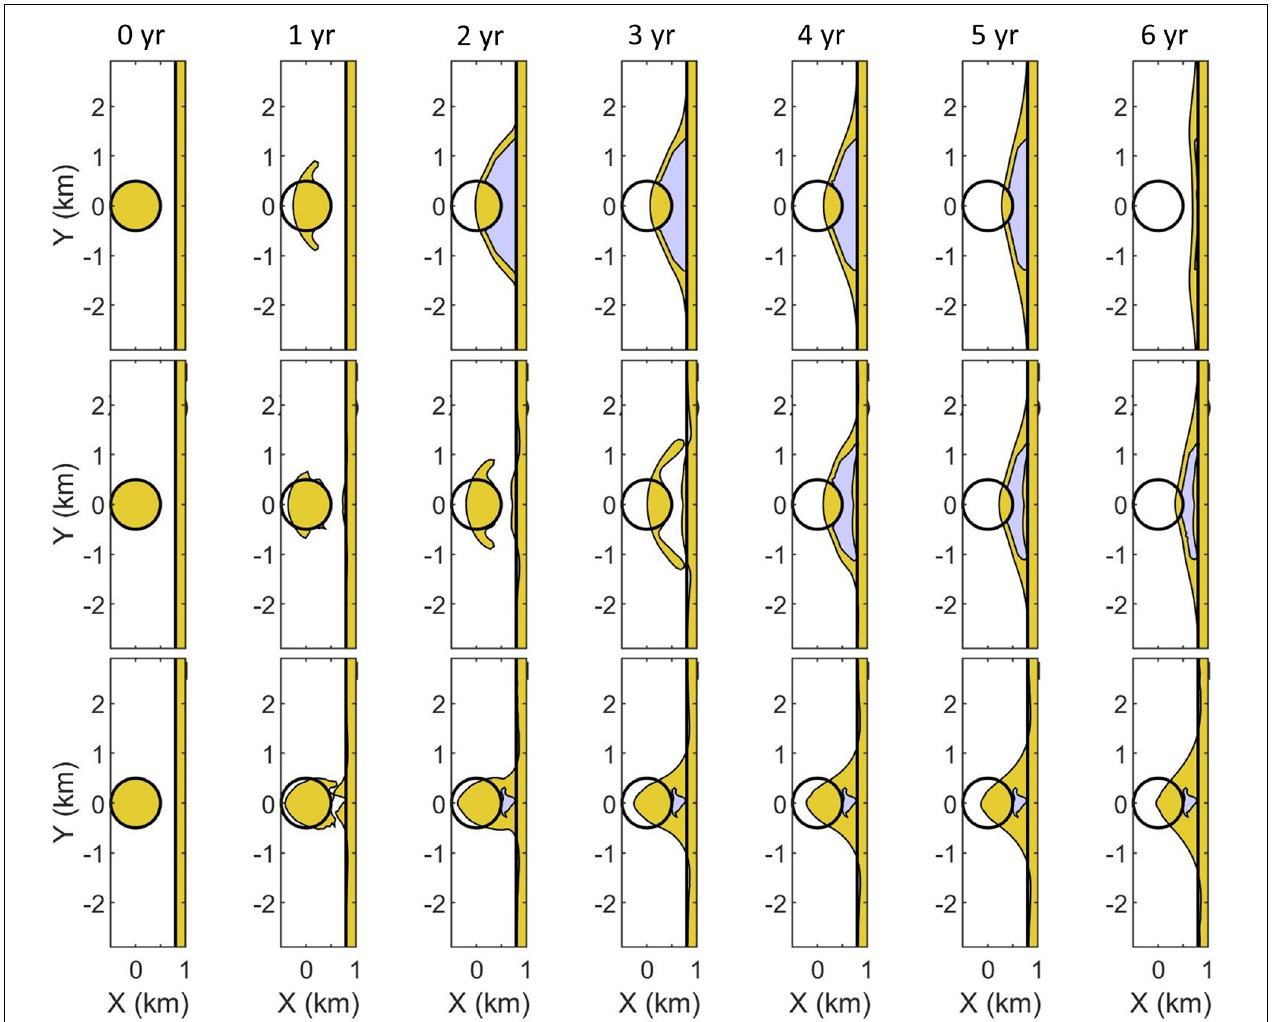
FIGURE 7 | Evolution of an island merging with the coast, for a critical spit width of 100 m. Top row: directional spreading 0 ◦ ; middle row : 90 ◦ and bottom row: 180 ◦ . Time between subsequent figures approximately 1 year.